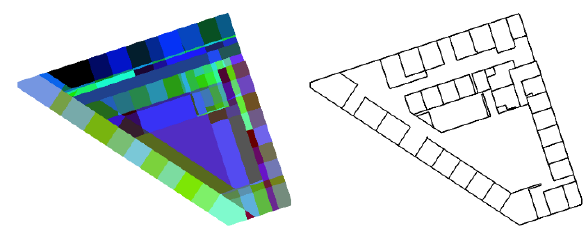
Figure 8. Door detection evaluation; greens indicate the successfully detected doors, while reds are missing, and oranges are false